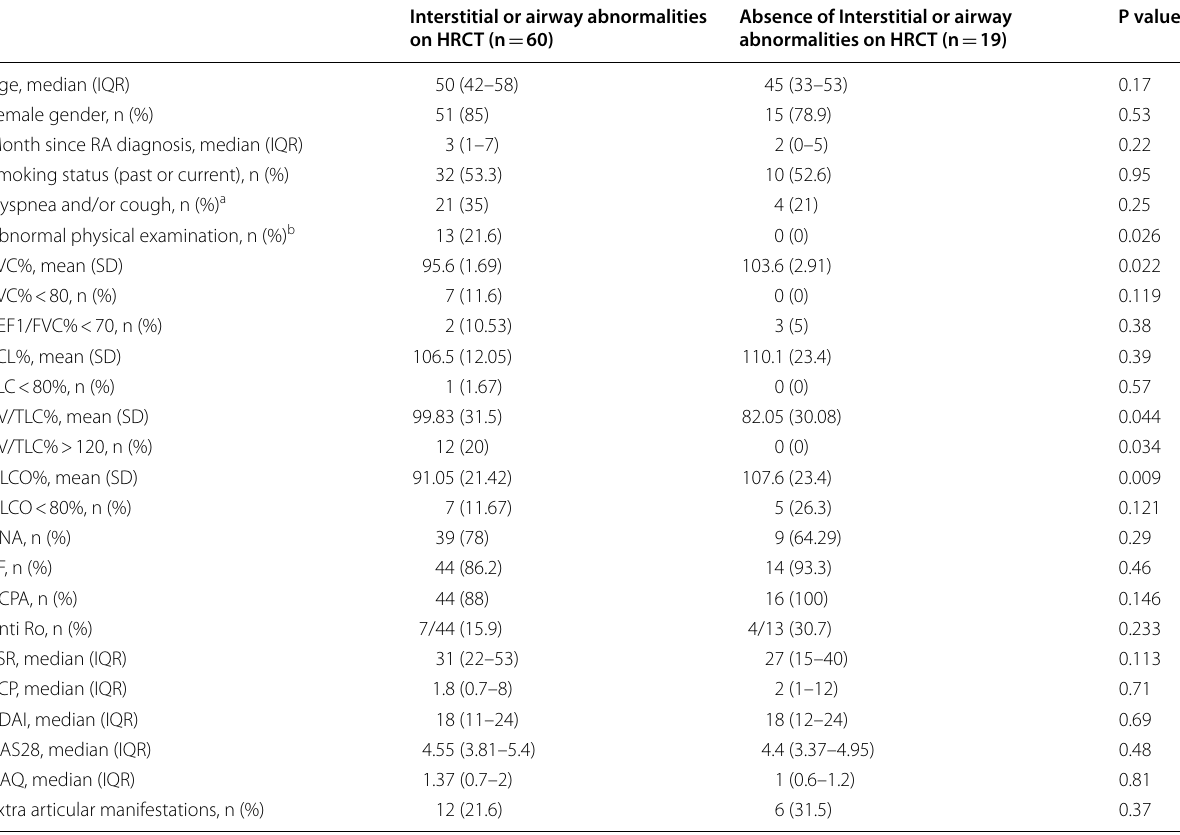
a Dyspneagreater the I mMRC b Rochus, wheezing or crackles on auscultation, or digital clubbing on